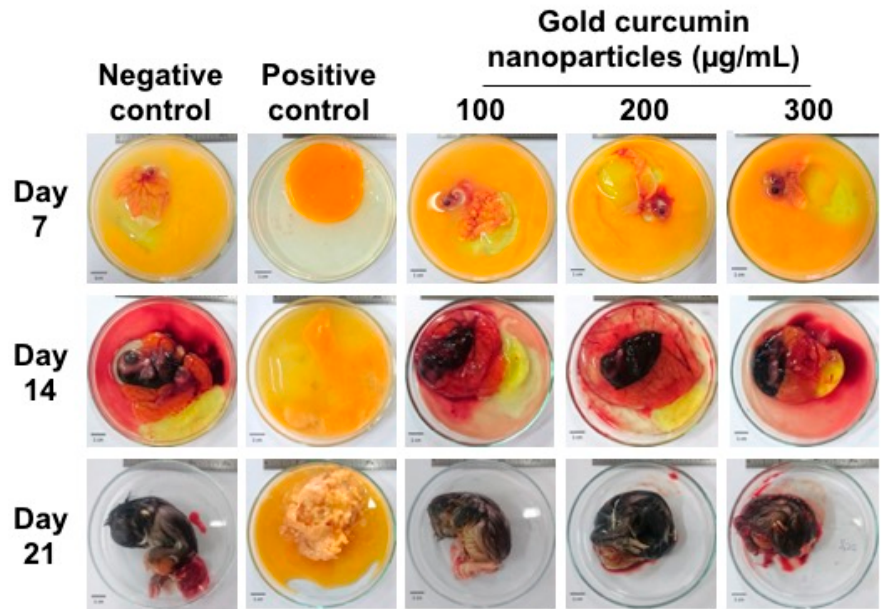
Figure 10. In ovo toxicity test of curcumin gold nanoparticles evaluated for 21 days. The chicken embryo were treated with 100, 200, and 300 μ g/mL curcumin-gold nanoparticles. The positive control group was treated with toluene and the negative control group did not receive any treatment.